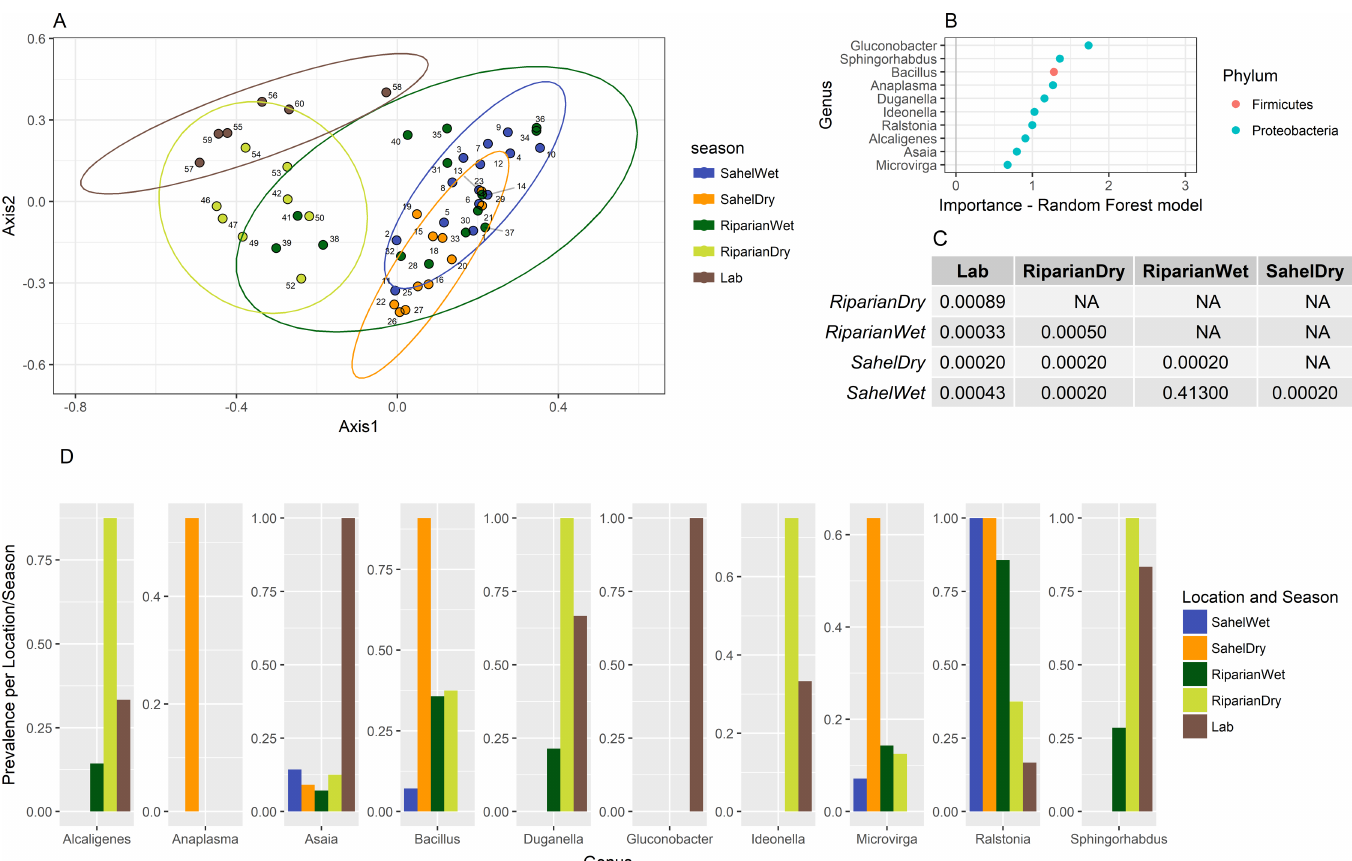
Fig 4. Random forest supervised learning to discriminate season and location for each sample group. Analysis was performed on all samples (pooled and individuals) for each location. The top ten variables (genera) important to the created model are shown in Panel B. Significantly different center points in the ordination via PERMANOVA are present in Panel C. Prevalence of the genera for each sample group is presented in Panel D.